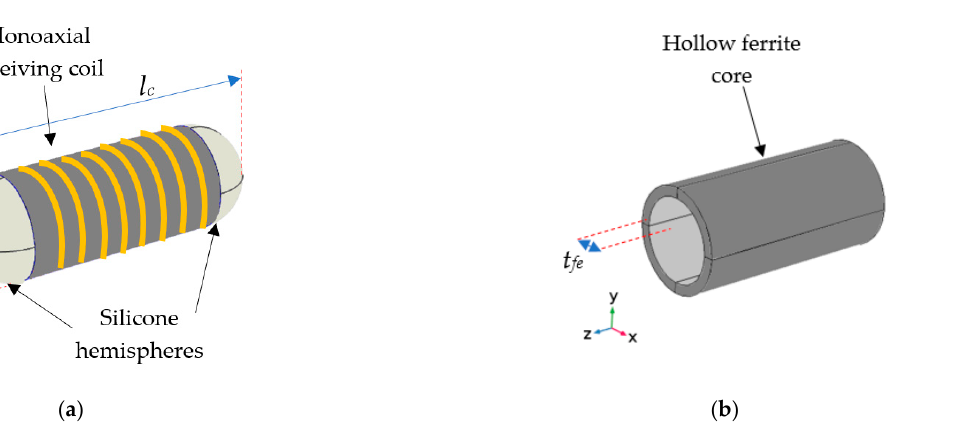
Figure 2. Capsule with monoaxial coil (in yellow) wound over a layer of ferrite covering the body of the cylindrical capsule ( a ) and layer of ferrite ( b ).